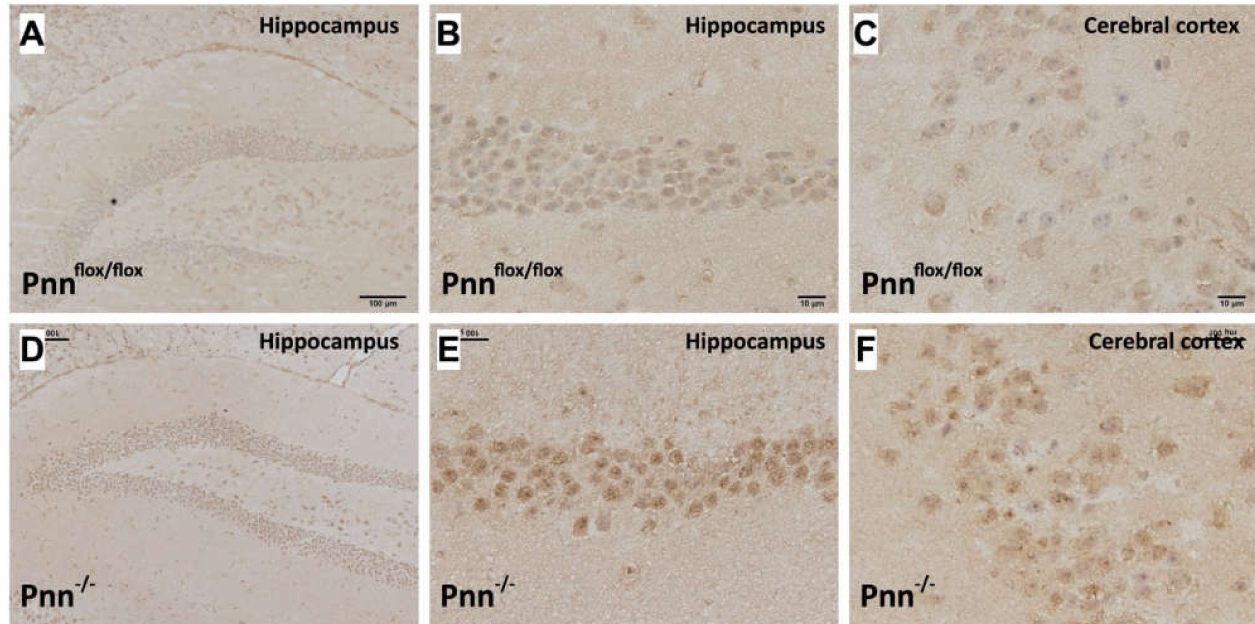
Figure 4. Increased oxidative stress in neurons with Pnn depletion. ( A – C ) OxyIHC to detect oxidized proteins in hippocampus and cerebral cortex of Pnn flox/flox mice. ( D – F ) OxyIHC to detect oxidized proteins in hippocampus and cerebral cortex of Pnn -/- mice. Results showed that the level of oxidized proteins (brown color) was increased in both hippocampus and cerebral cortex of mice with neuronal Pnn